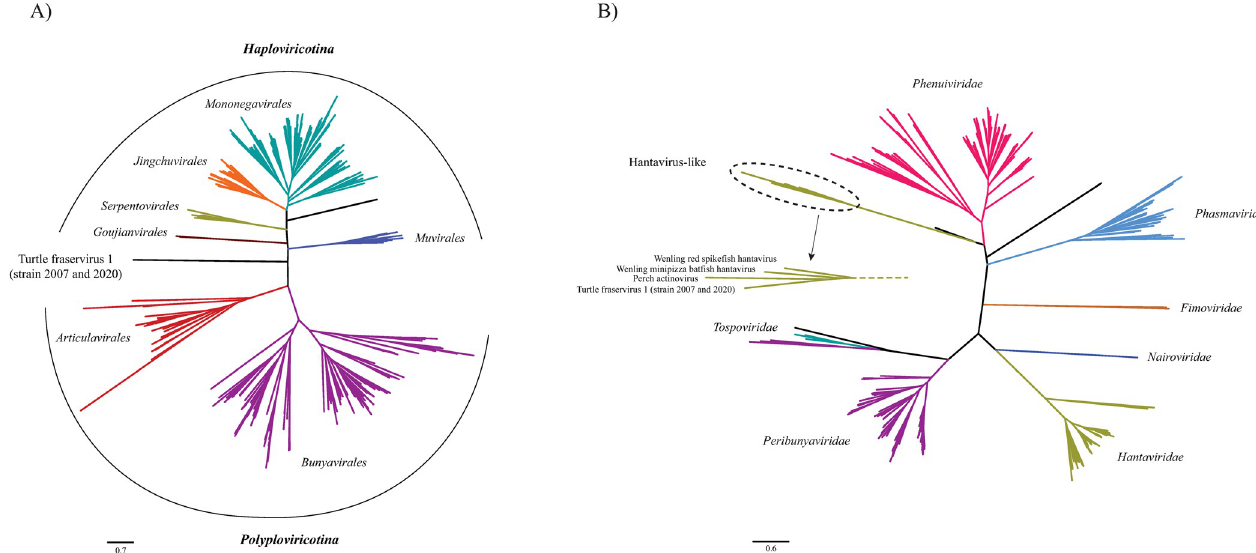
Fig 10. Phylogenies of the RdRP and GPC of the Turtle Fraservirus 1. A) Maximum likelihood tree (inferred with IQ-tree and the rtREV+F+R9 model) constructed from a collection of custom profiles for the RdRPs of all known negarnaviruses. Only the 7 order-level clades are shown (families and species within each clade are collapsed). B) Maximum likelihood tree (inferred with IQ-tree and the WAG+F+R9 model) constructed from a collection of bunyavirus- like glycoproteins. Only the 7 family-level clades are shown (species within each clade are collapsed). Scale bars indicate average amino acid substitutions per site. Both trees are